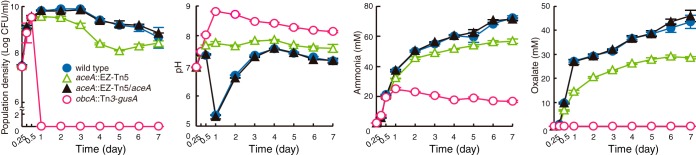
Cell viability, extracellular pH, and ammonia and oxalate production of the aceA mutants of B. glumae. Viable cell numbers of the aceA mutant of B. glumae were decreased by approximately 10% compared to that of wild-type strain, and the extracellular pH of the aceA mutant was maintained at 7.6 to 7.9 throughout growth, whereas the wild-type strain showed acidification and neutralization patterns. Ammonia production by the aceA mutant was slightly lower than that by the wild-type strain, and oxalate production by the aceA mutant was ~60% that of wild-type strain.